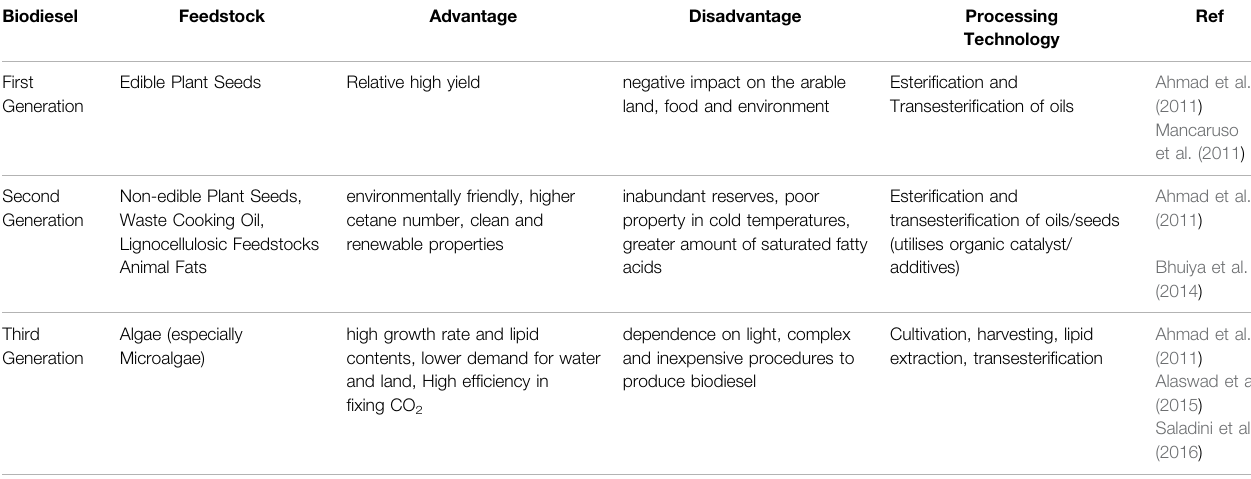
TABLE 1 | Differences of three generations of